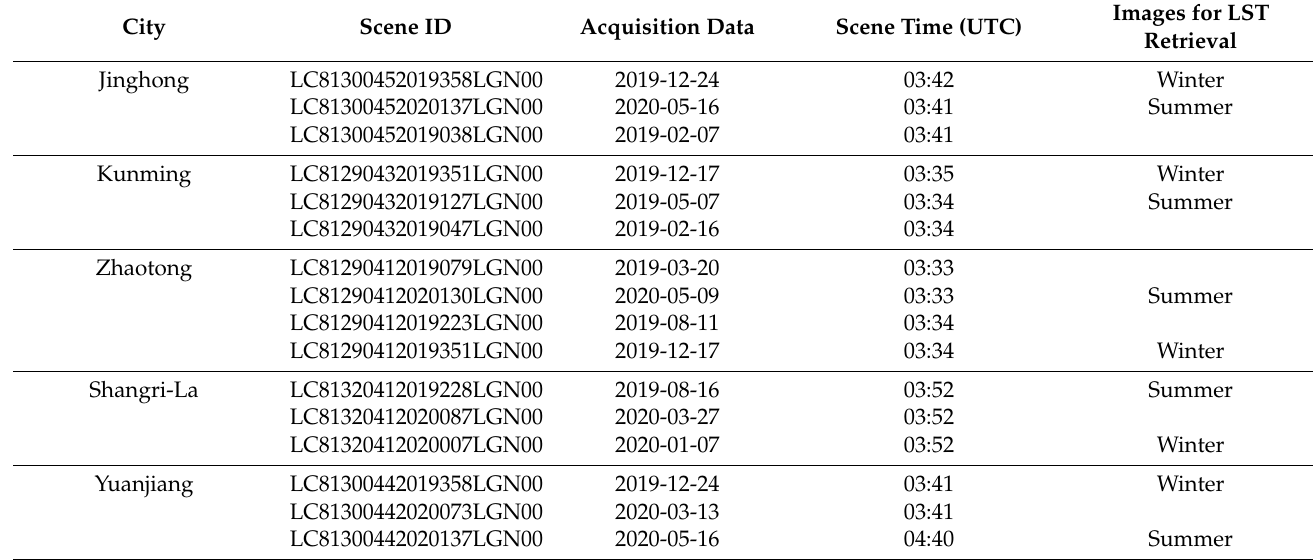
Table A1. Information on Landsat images for LCZ mapping and LST retrieval.